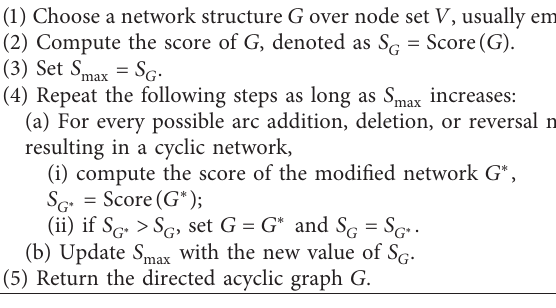
Table 1: Hill-Climbing